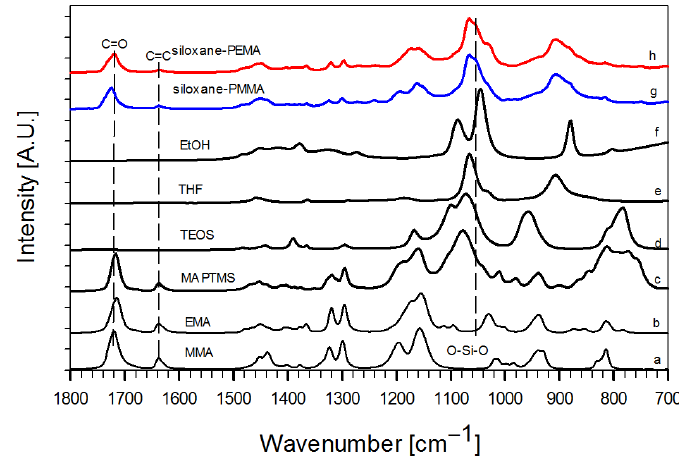
Figure 1. FTIR absorption spectra of ( a ) MMA, ( b ) EMA, ( c ) MAPTMS, ( d ) TEOS, ( e ) THF, ( f ) EtOH, ( g ) siloxane-PMMA and ( h ) siloxane-PEMA sols. Spectra were recorded for freshly prepared sols without further curing treatment.